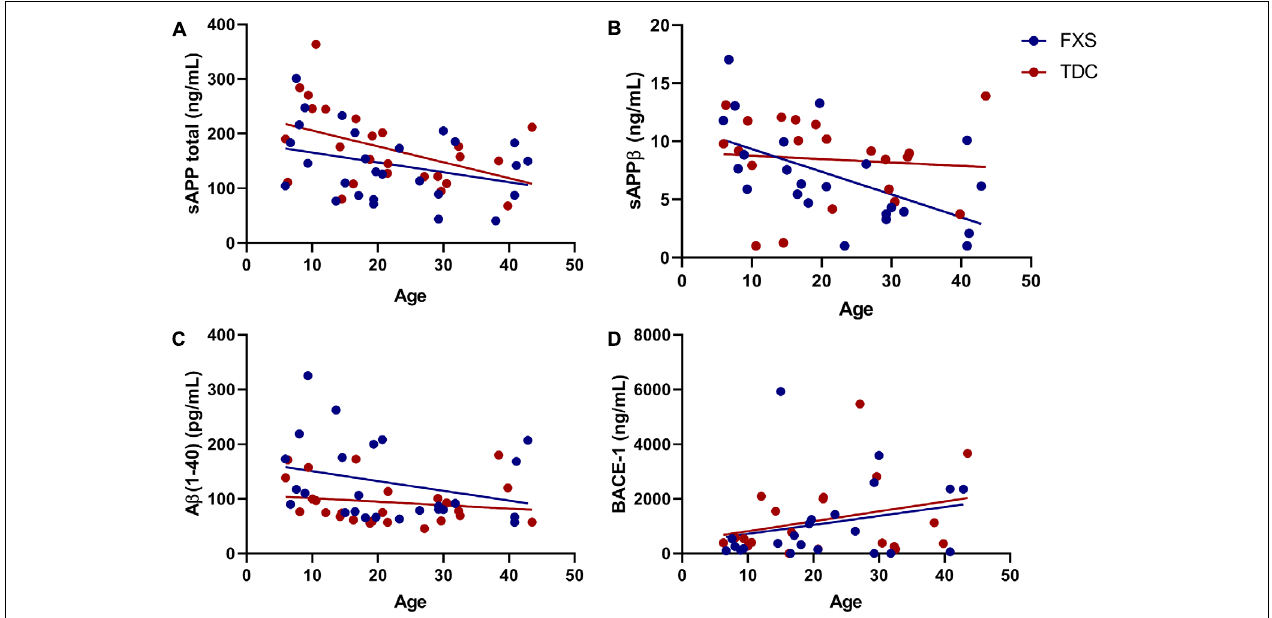
FIGURE 3 | BACE-1 activity may decrease with age. Levels of sAPP total, sAPP β , A β (1 − 40), and BACE-1 captured by ELISA were analyzed with respect to subject age. (A) The expression of sAPP total decreases significantly in both FXS and TDC groups with respect to age ( p = 0.0112). (B) The expression of sAPP β decreases significantly in both FXS and TDC groups with respect to age ( p = 0.0074). (C) A β (1–40) appears to be elevated in younger FXS patients and seems to decrease with age ( p = 0.0644). (D) BACE-1 expression tended to increase with age although this trend did not reach statistical significance ( p =